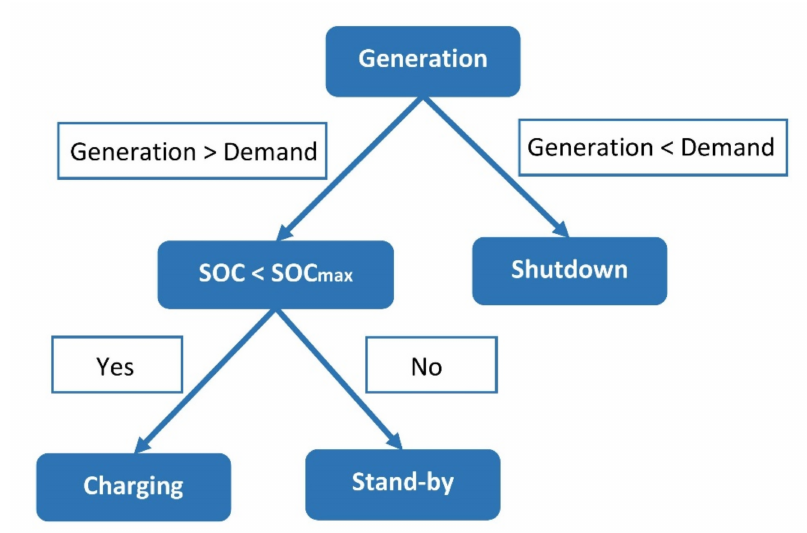
Figure 1. Example of a decision tree